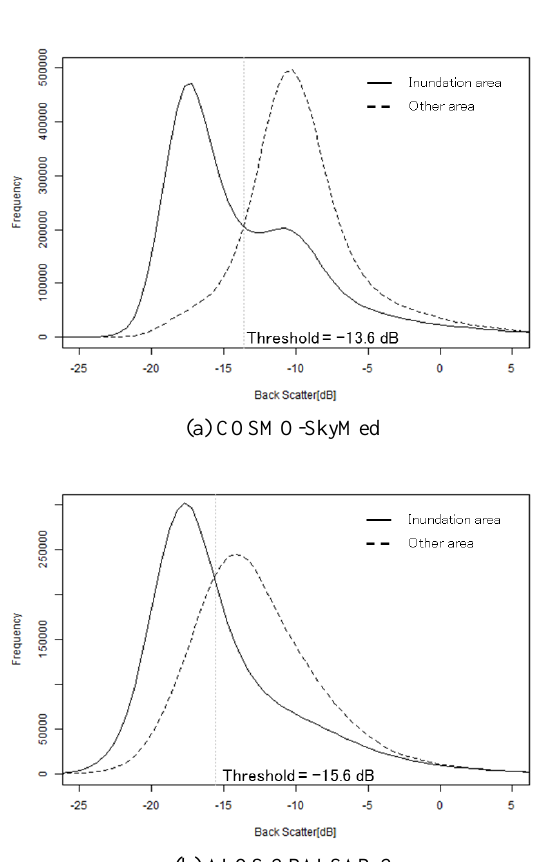
Figure 3. Histograms of backscatter coefficient for inundated areas and other areas